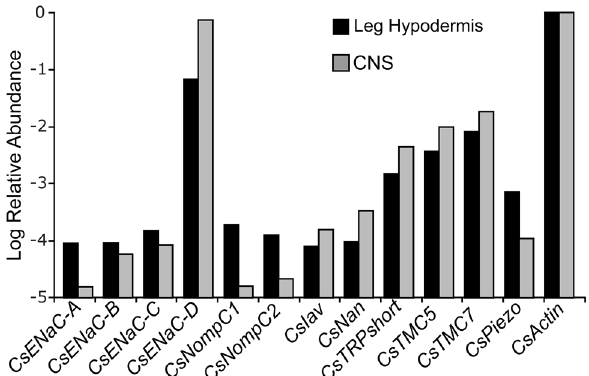
Figure 1. Relative abundances of putative mechanotransduction channel transcripts in C. salei leg hypodermis and CNS transcriptomes compared to the actin abundance. These data were obtained by counting total reads